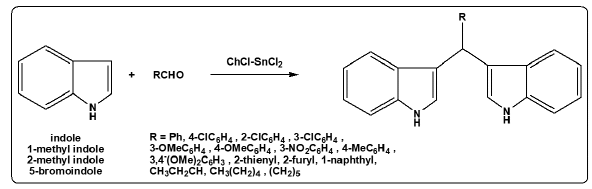
Figure 13: Condensation reaction of aldehydes and indoles catalysed by ChCl-SnCl . i 2 i See Azizi and Manocheri [75] for detailed reaction components and conditions.